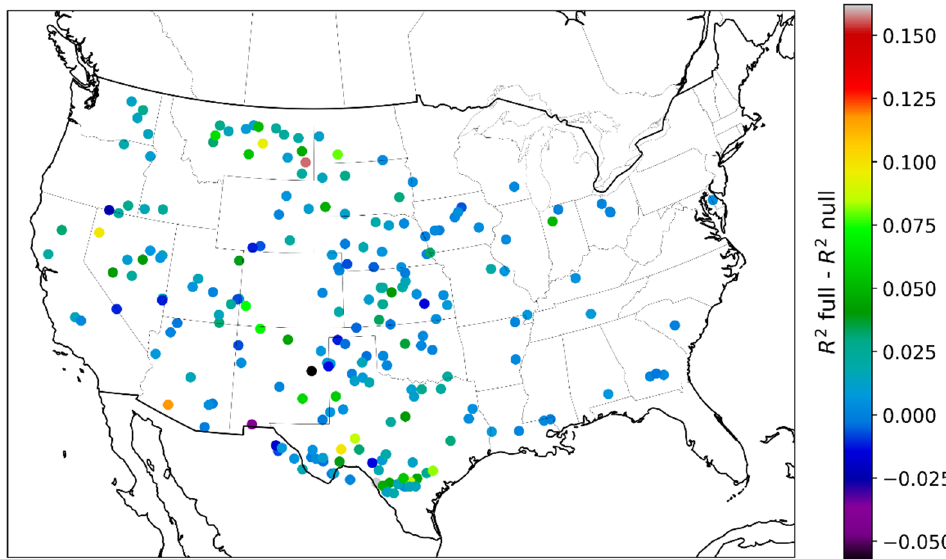
Figure 4. The R 2 s of reconstructed LAI by adding “ full ” model predicted and “ null ” model predicted LAI anomalies to LAI climatology against the R 2 s of LAI climatology ( a ), and the ubRMSE of reconstructed LAI by adding “ full ” model predicted and “ null ” model predicted LAI anomalies to LAI climatology against the ubRMSE of LAI climatology ( b ).